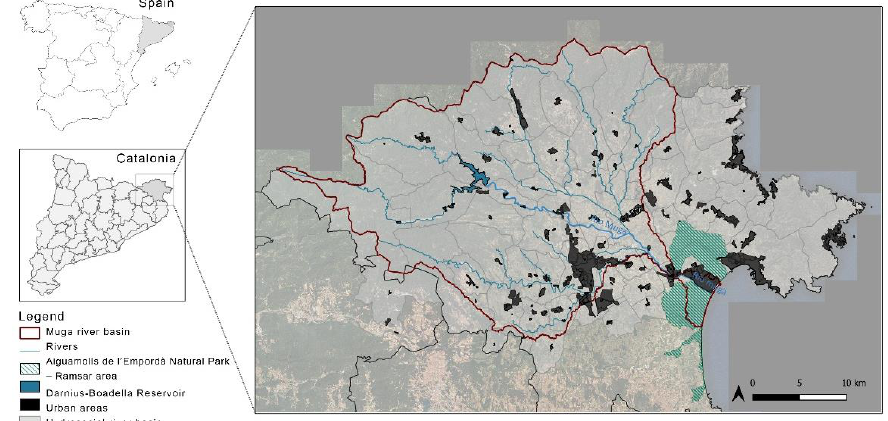
Figure 1. Territorial framework of the Muga river basin.